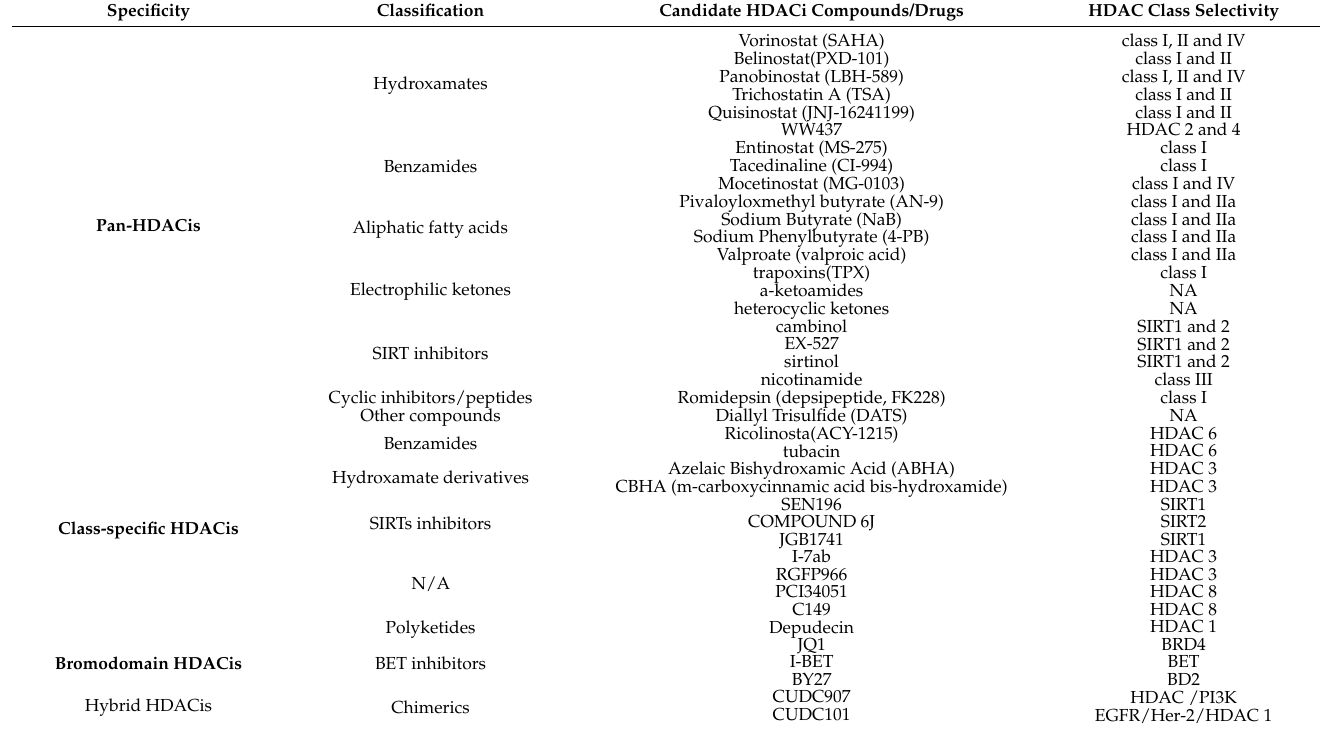
Table 2. Table showing different HDACi categorized based on their class, chemical identity, specificity, and HDAC class